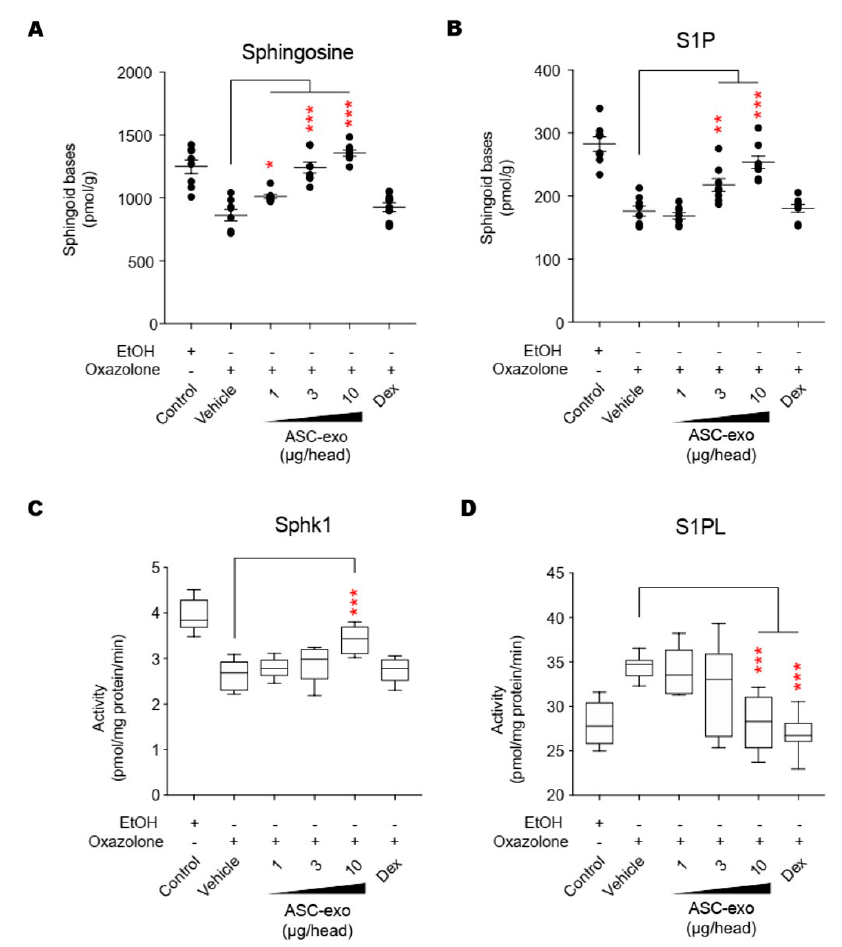
Figure 11. ASC-exosomes regulate the salvage pathway to increase ceramides in skin lesion. ( A – D ) The levels of sphingosine and S1P, and the activities of Sphk1 and S1PL were determined by LC-MS/MS measurements. Error bars depict the SEM. n = 8. *: p < 0.05, **: p < 0.01, ***: p < 0.001 vs. vehicle. Dex, dexamethasone.